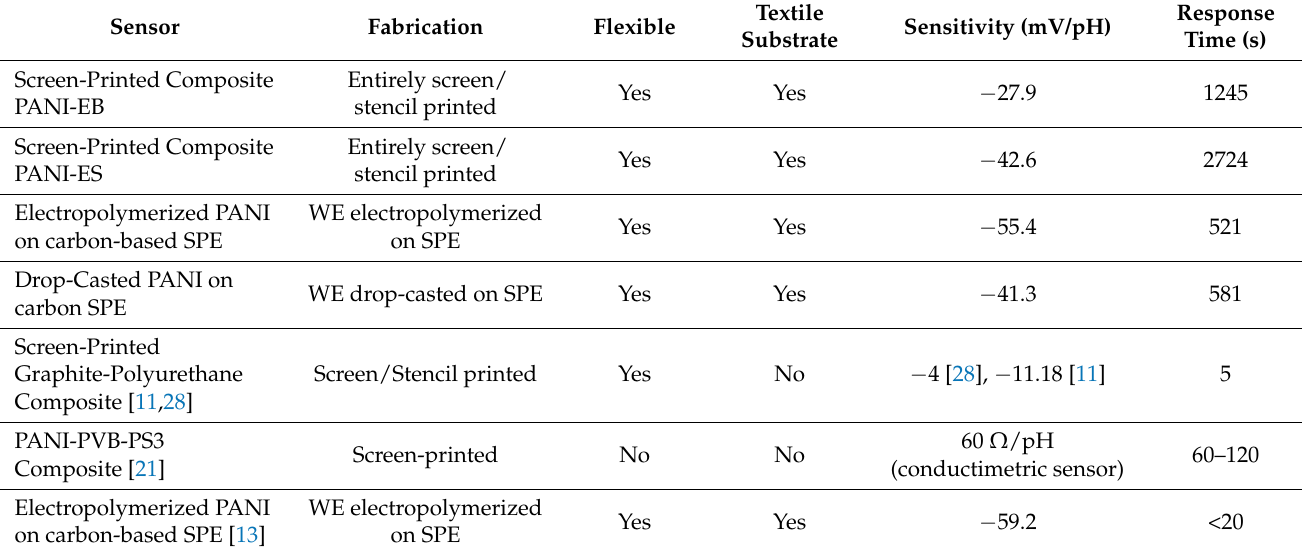
Table 4. Comparison of fabrication, flexibility, sensitivities, and response times of sensors described herein and select literature values. It should be noted that the sensors described herein achieve 90% of their steady state OCP response in less than half the listed response times